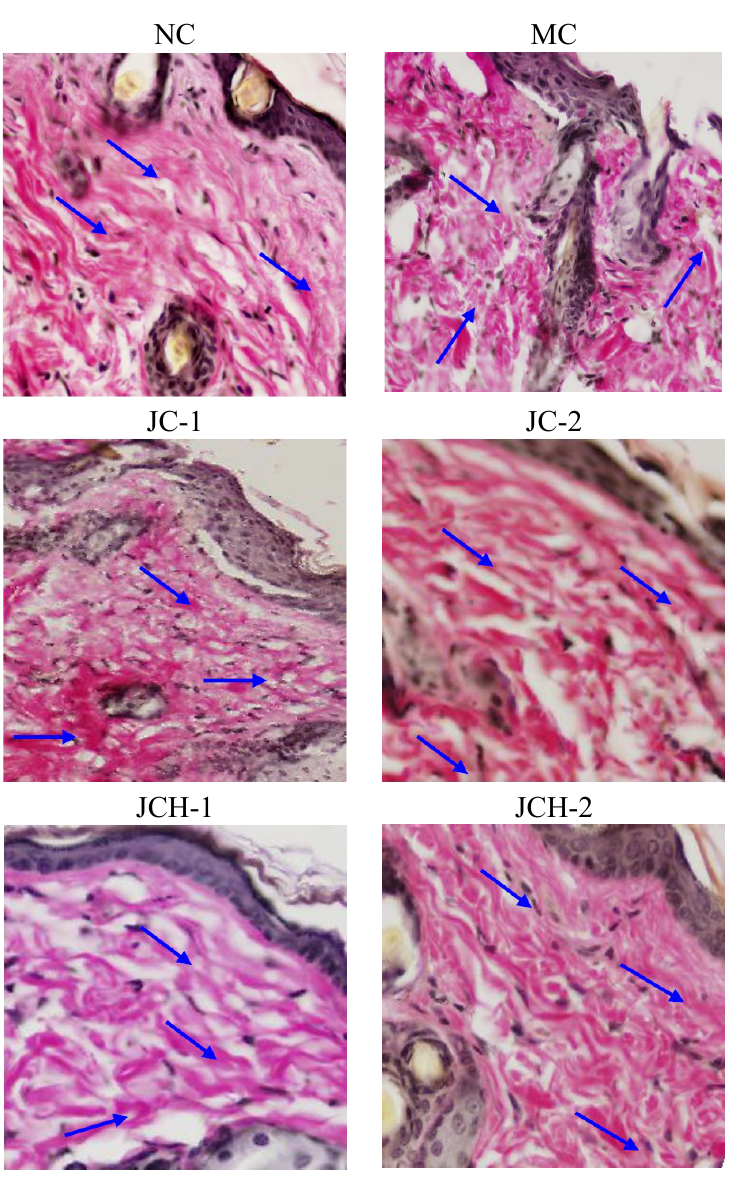
Figure 2. The effect of JC and JCH on endogenous collagen of photoaging skin (magnification 200×); Red: collagen (